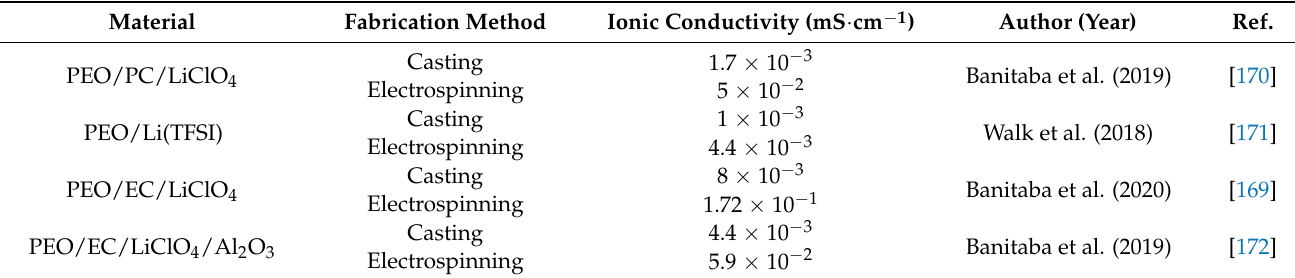
Table 4. Ionic conductivity of the electrospun and solution-casted membranes with similar chemical compositions. Material Fabrication Method Ionic Conductivity (mS · cm − 1